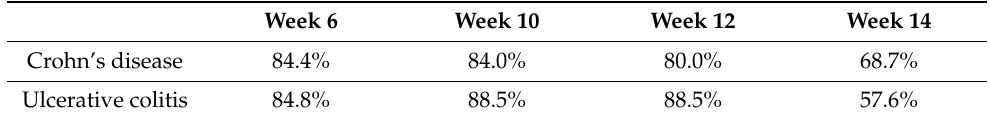
Table 2. Number of patients with CD and UC who achieved CT-P13 level of 3 µ